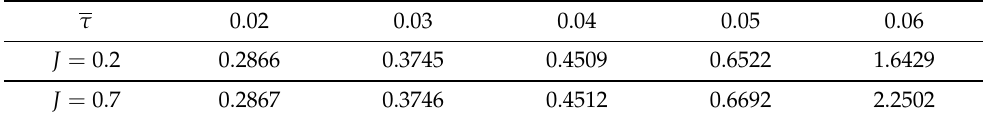
Table 4. Minimum γ for various of τ and J values in Case 2.